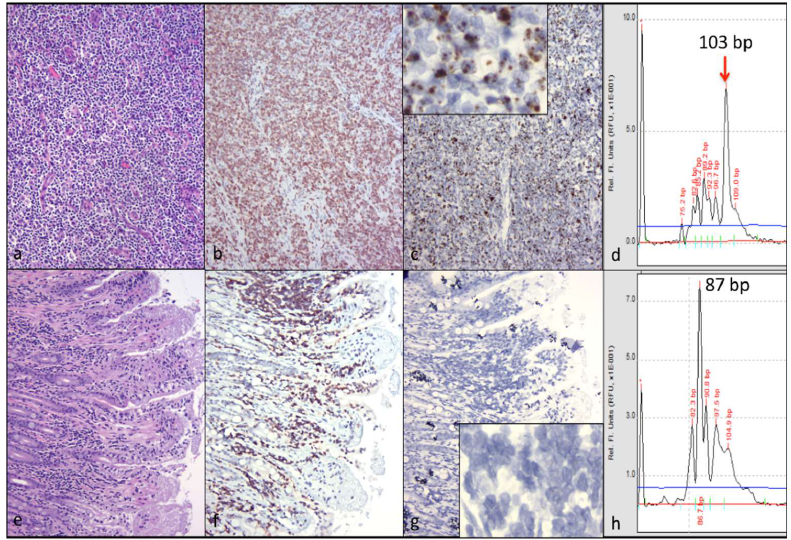
Figure 3. Clonally distinct, CD3+ T cell lymphomas are present in the cervical lymph nodes and the mucosa of the small intestine (jejunum). ( a ) The architecture of the cervical lymph node (LN) is effaced by sheets of neoplastic lymphocytes (hematoxylin and eosin stain); ( b ) The neoplastic lymphocytes within the cervical LN are CD3+ T cells (CD3 IHC); ( c ) Diffuse neoplastic lymphocytes within the cervical LN contain brown aggregating granules (positive for viral nucleic acid, in-situ hybridization); inset shows high-power magnification of neoplastic lymphocytes demonstrating brown granular material (viral nucleic acid); ( d ) A monoclonal PCR amplicon derived from the cervical lymphoma lesion is 103 base pairs (bp) long (T cell receptor gamma locus (TRG) clonality); ( e ) A poorly-delineated band of lymphocytes infiltrates the base of the mucosal villi within a segment of jejunum (hematoxylin and eosin stain); ( f ) The infiltrating lymphocytes are CD3+ (CD3 IHC); ( g ) Essentially, no brown granular material is present in these infiltrating lymphocytes (undetectable viral nucleic acid). Inset: high-power magnification; ( h ) A monoclonal PCR amplicon derived from the intestinal lesion is 87 bp long (TRG